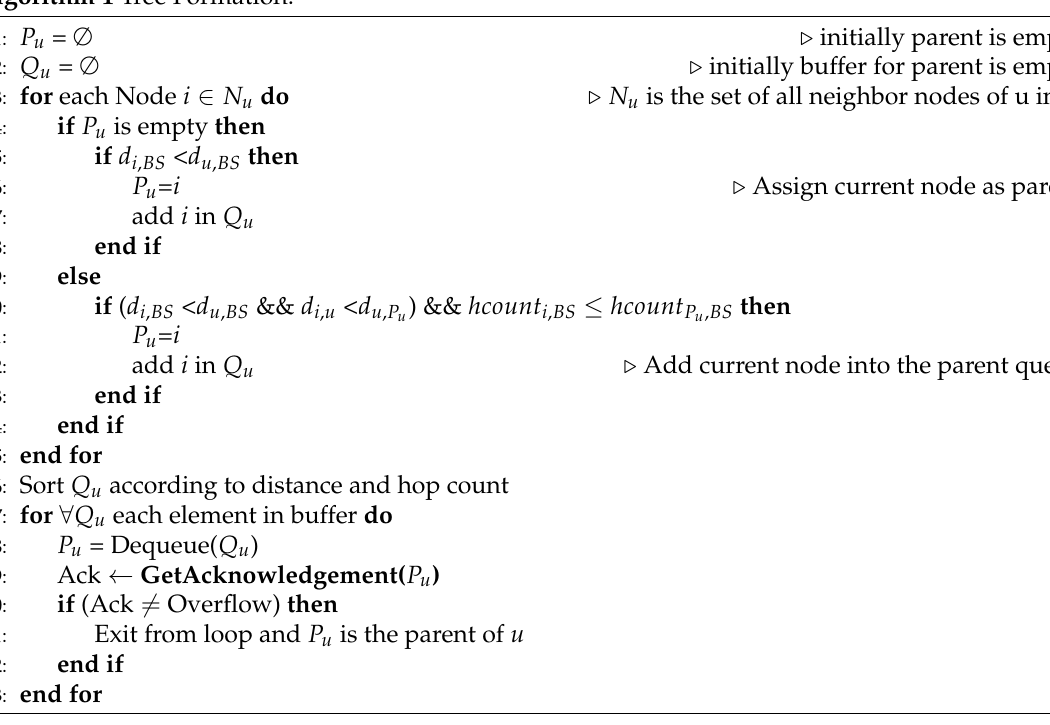
Algorithm 1 Tree Formation.